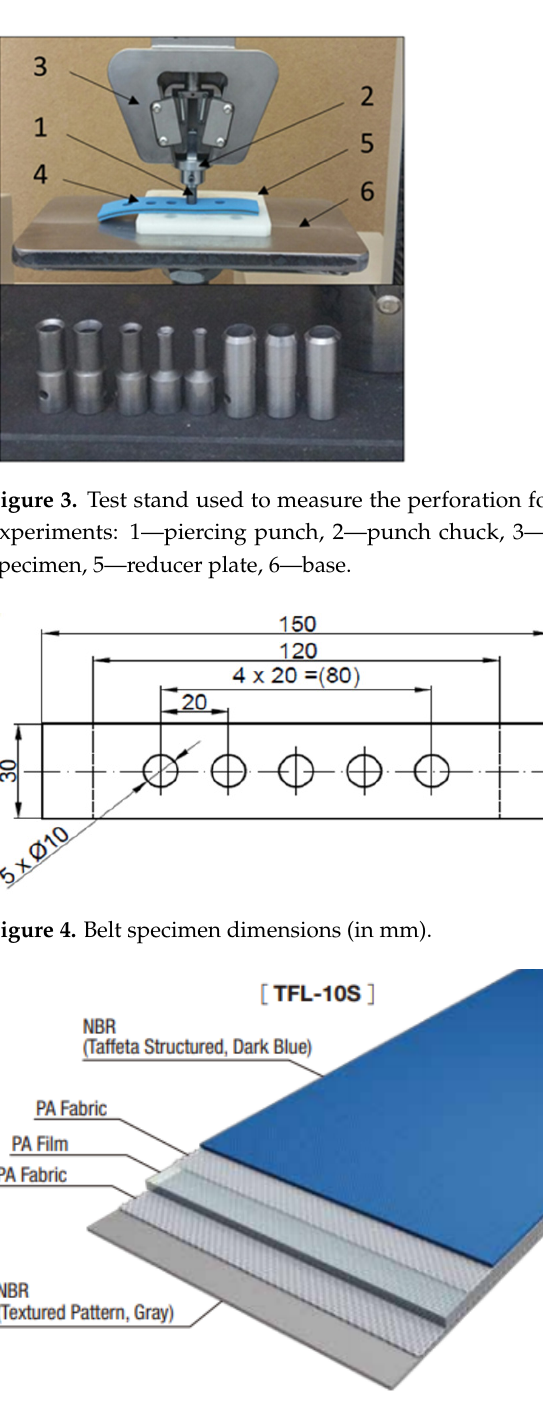
Figure 5. TFL10S belt (Nitta ® Polybelt TM ).